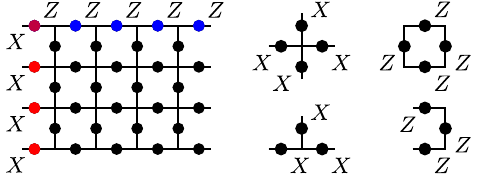
FIG. 3. Standard 4 × 5 surface code, with logical operators given by a product of X along the left edge and a product of Z along the top edge. Stabilizer generators are shown at the right.